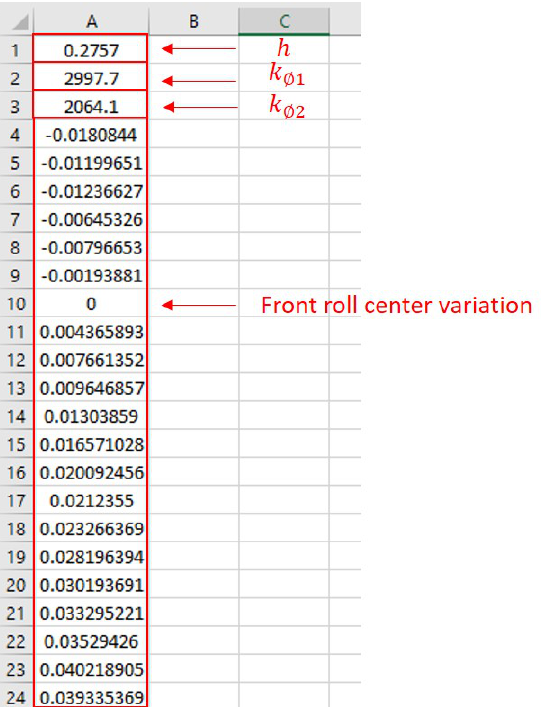
Figure 28. Output vector of the neural network.